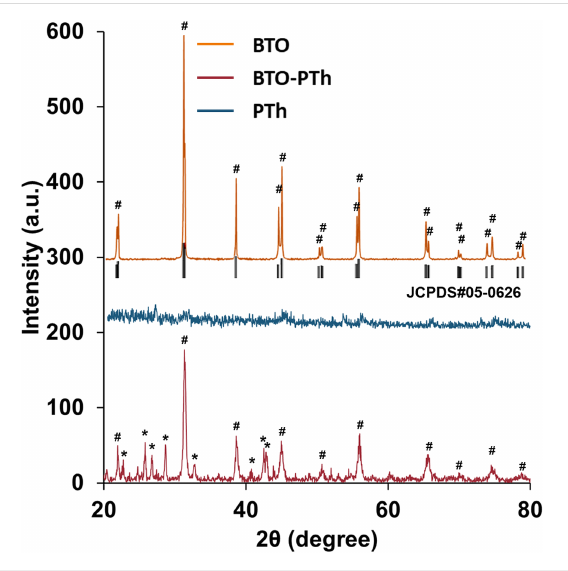
Figure 3: XRD patterns of the as-prepared BTO nanoparticles, pris- tine PTh, and core–shell BTO-PTh nanoparticles. The diffraction peaks denoted by (#) correspond to the tetragonal BTO lattice (JCPDS No. 05-0626), while peaks denoted by (*) correspond to the orthorhombic BaSO 4